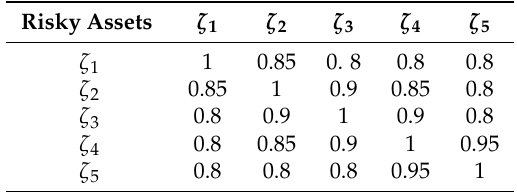
Table 4. Asset correlations among loans of a market in